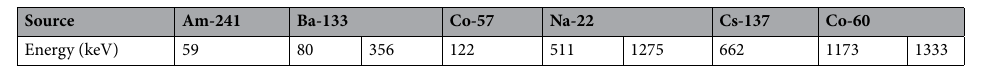
Table 8. Gamma radioisotope sources for